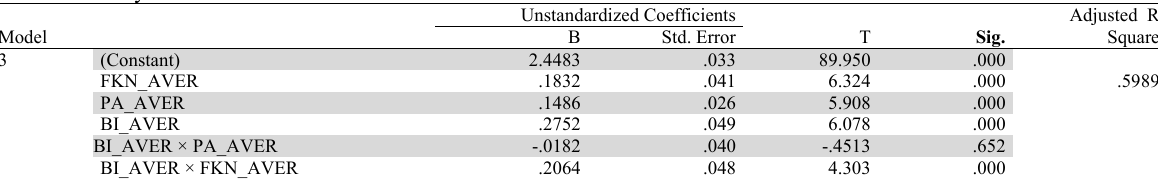
Model summary 3